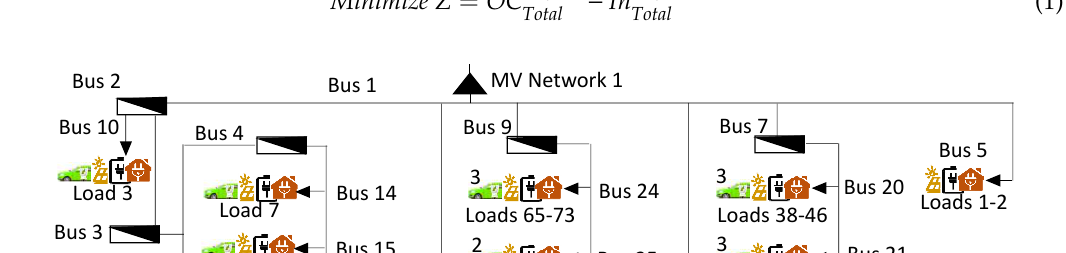
Table 3. Specifications of SMG [16].